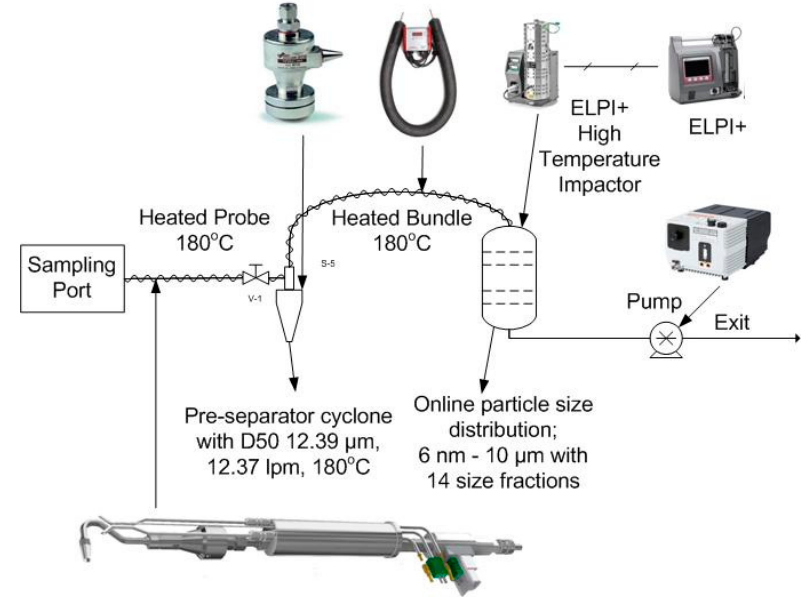
Figure 2. Sampling system sketch.